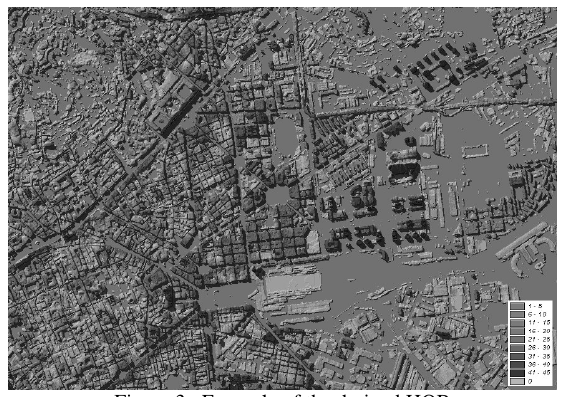
Figure 3. Example of the derived HOB